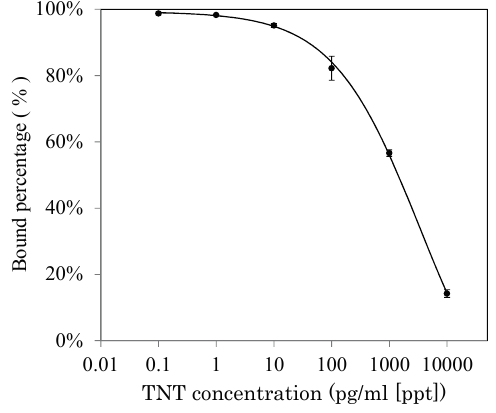
Figure 6. Response curve for TNT by inhibition assay using 100 ng/mL (100 ppb) TNT–Ab. The error bar refers to the SD [46].